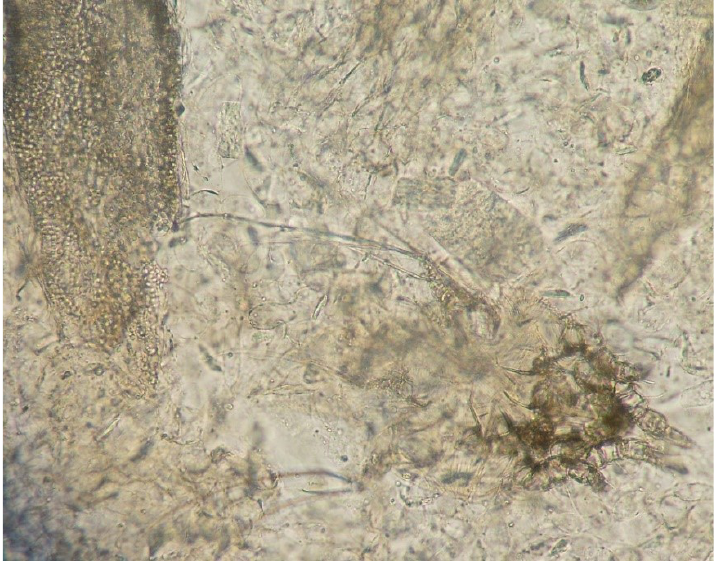
Figure 3. Direct examination of a skin scraping: hair invaded by fungal structures (arthroconidia) (left) and C. bovis mite (right) (10× magnification).